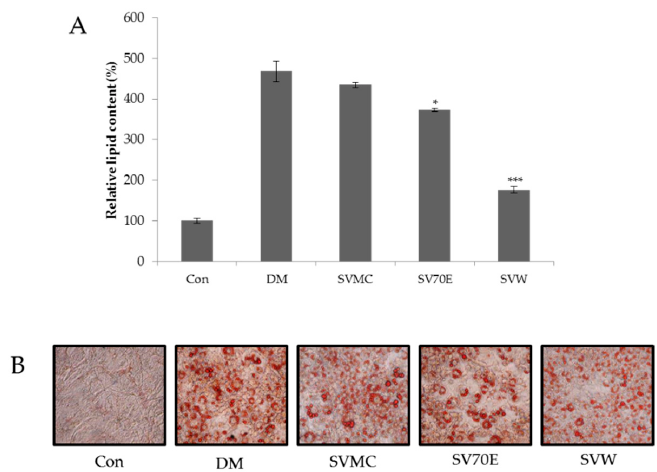
Figure 1. Effect of the SV extracts on inhibition 3T3-L1 adipocyte differentiation. ( A ) The relative lipid content; ( B ) Oil Red O staining images. Stained triglyceride content was quantified by measuring absorbance at 540 nm. Con is control group; DM is differentiation media cells; SVMC is methyl chloride extract of S. virgaurea var. gigantea, SV70E is 70% ethanol extract of S. virgaurea var. gigantea; SVW is water extract of S. virgaurea var. gigantea. The concentration is 10 μ g/ml; three independent experiments have been carried out; * p < 0.05 vs. DM; *** p < 0.005 vs. DM.